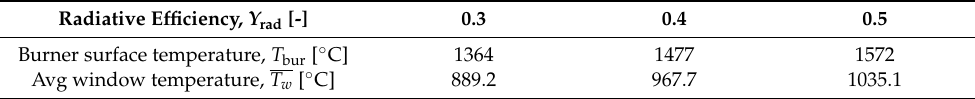
Table 4. Influence of burners radiative efficiency on burner surface temperature and average win- dow